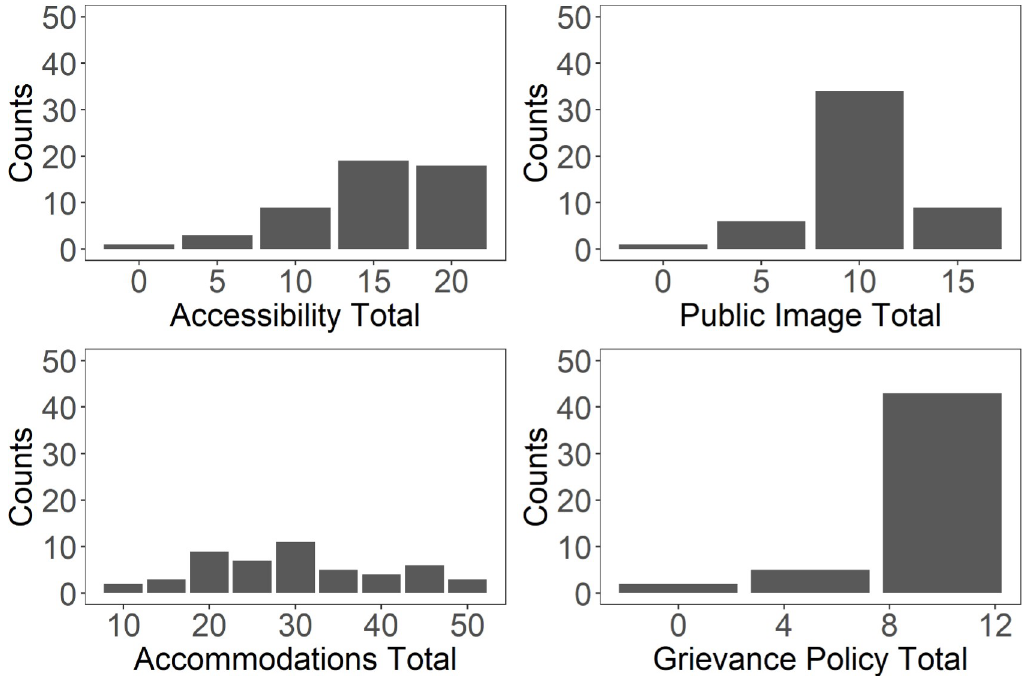
Fig 2. Count of institutions receiving each point allotment for the four scored